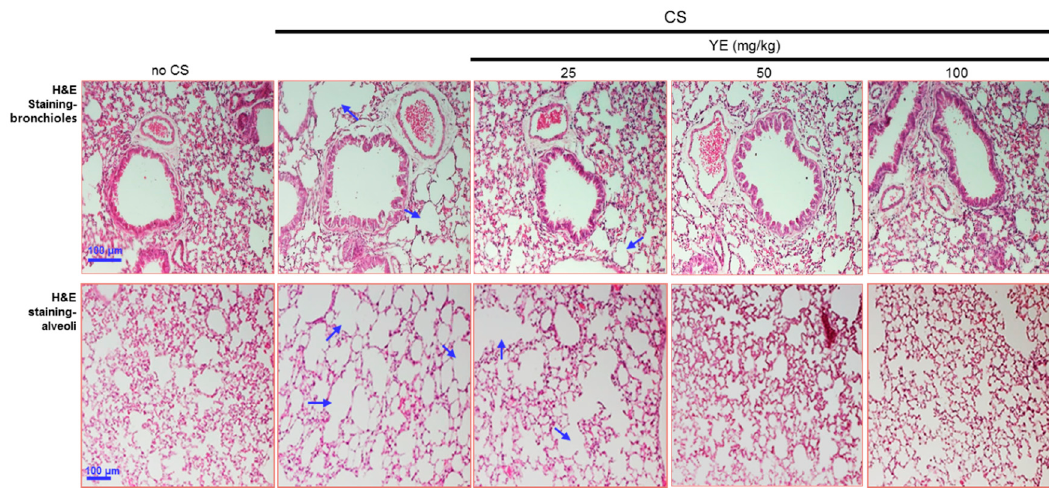
Figure 2. Blockade of airway destruction by dried yeast extracts (YE) in cigarette smoke (CS)-challenged mouse bronchioles and alveoli. Mice were orally administrated with 25–100 mg/kg YE and exposed to CS for 30 min. Airway tissue sections were stained by using a hematoxylin and eosin (H&E) reagent. Each photograph is representative of four mice. The arrows indicate damaged bronchioles and alveolar air sacs. Scale bars = 100 µm.